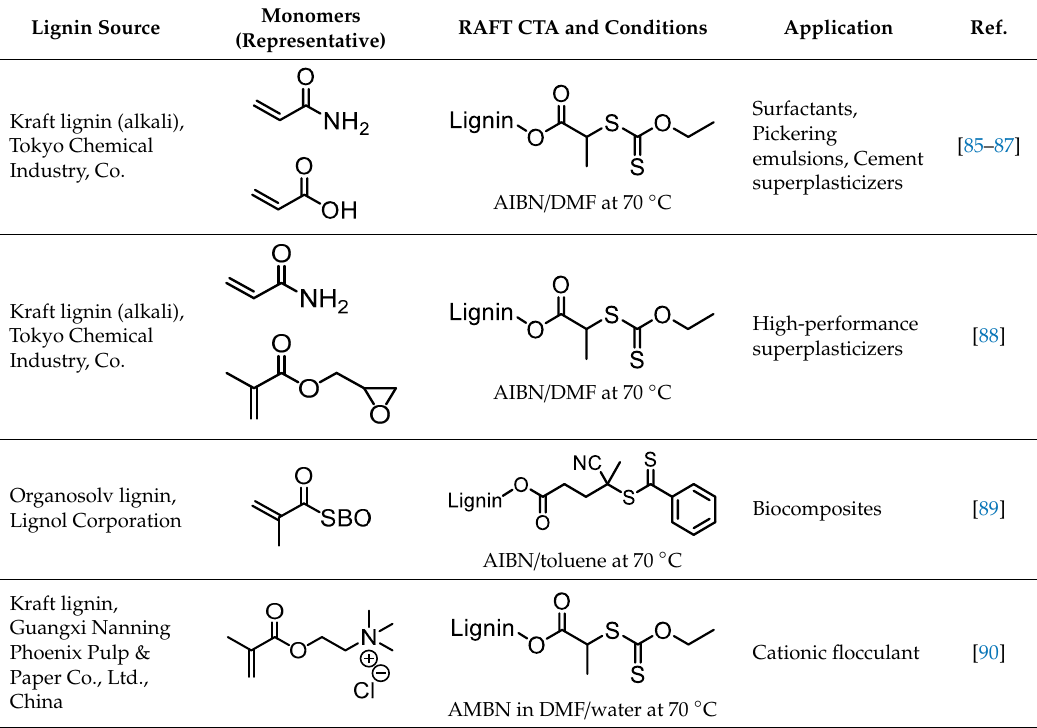
Table 3. Summary of recent literature on RAFT grafting from modifications on lignin.